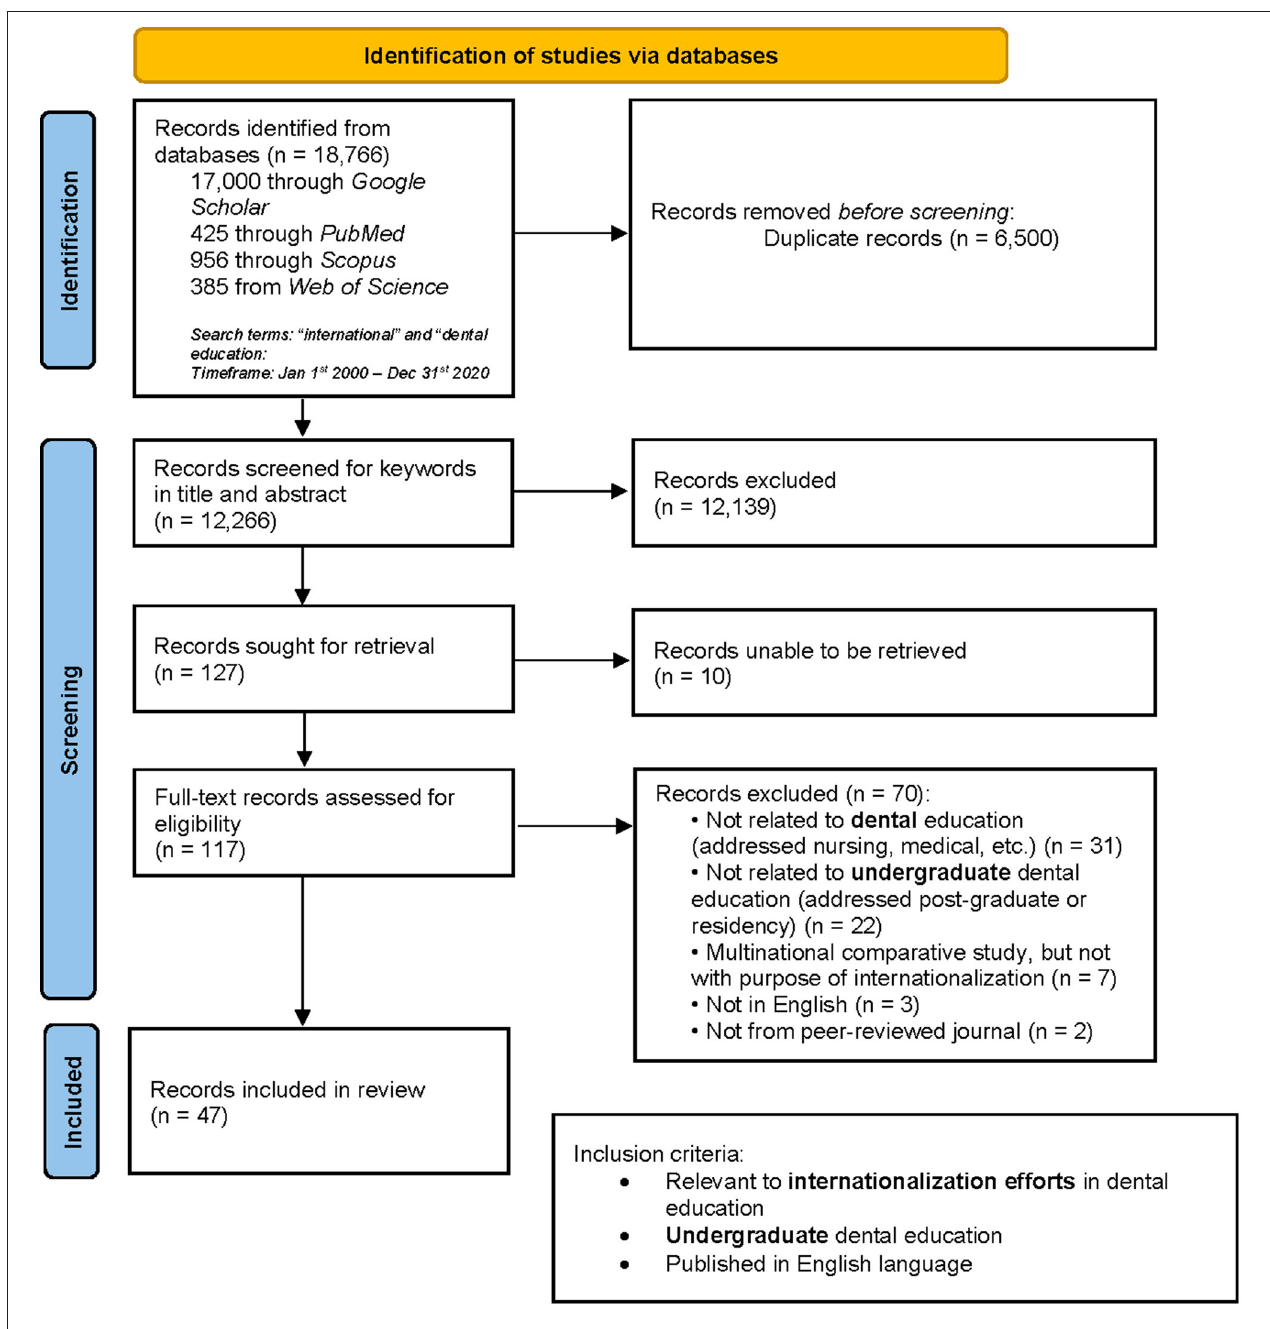
FIGURE 1 | PRISMA diagram of selection